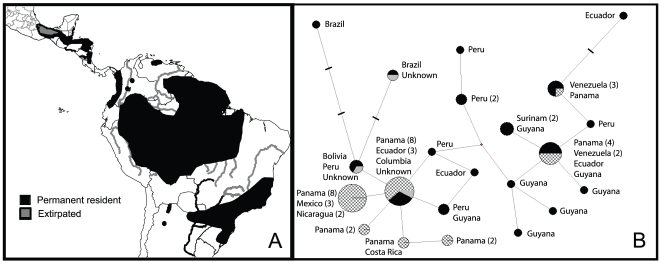
Harpy eagle geographic distribution (A) and haplotype network (B).Median-joining network (B) depicting relationships among control region haplotypes from harpy eagles sampled in South America (black), Central America (hatched) and three individuals of unknown origin (grey). Circle size is proportional to the number of individuals with that haplotype. Small gray circles at nodes and dash marks along branches indicate nucleotide substitutions required to connect sampled haplotypes.